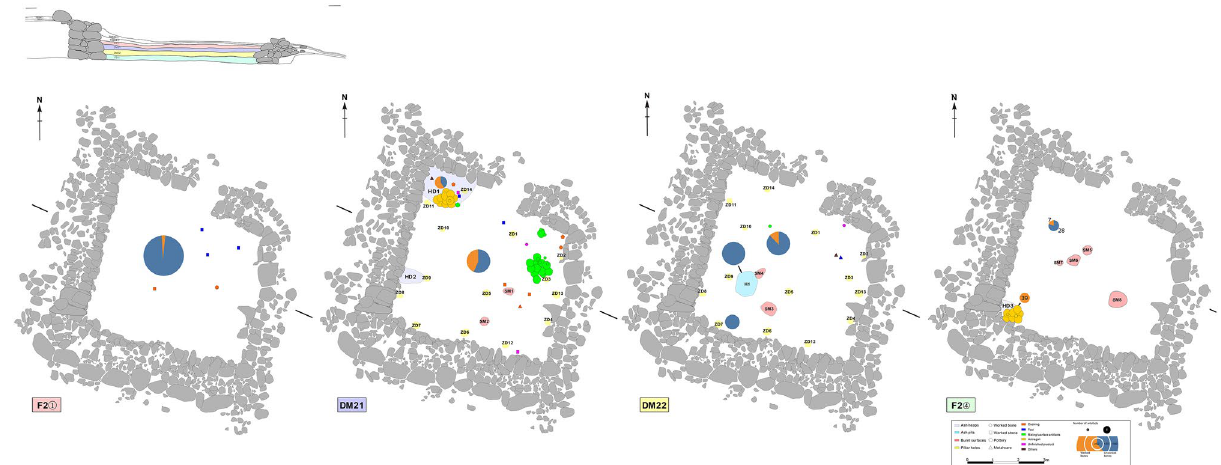
Figure 5. Plan of F2 divided according to stratigraphy with features and artefacts marked on each layer. The plan was mapped by J. M. and Y. W. and digitalized by J. M., Y. W. and F. M. using CorelDraw X8 https:// www. corel draw. com/ en/ pages/ corel draw-